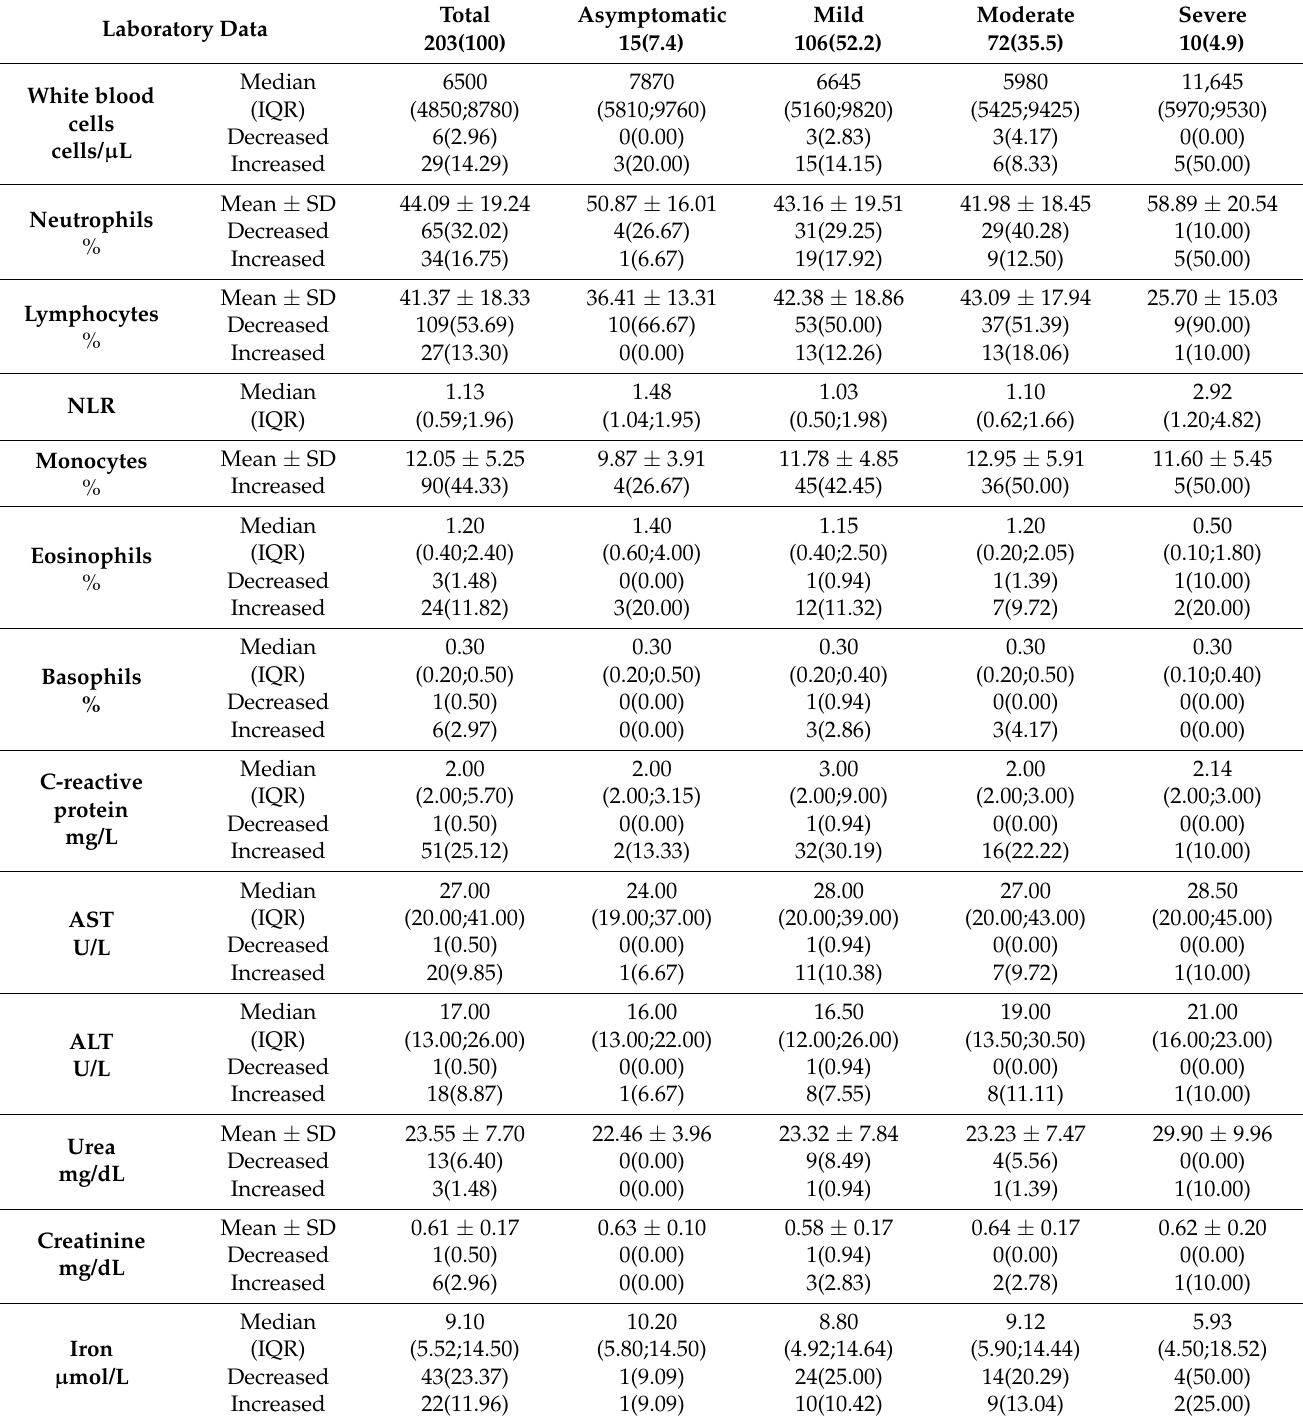
Table 2. Laboratory findings of patients on admission, stratified by clinical